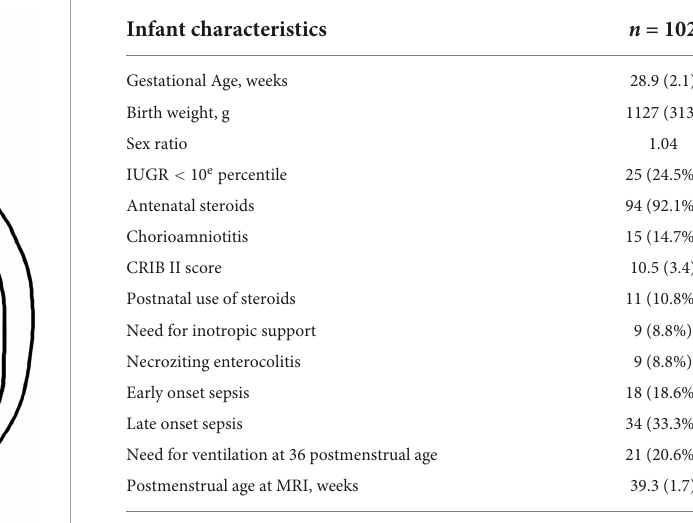
TABLE 1 Demographic data of preterm